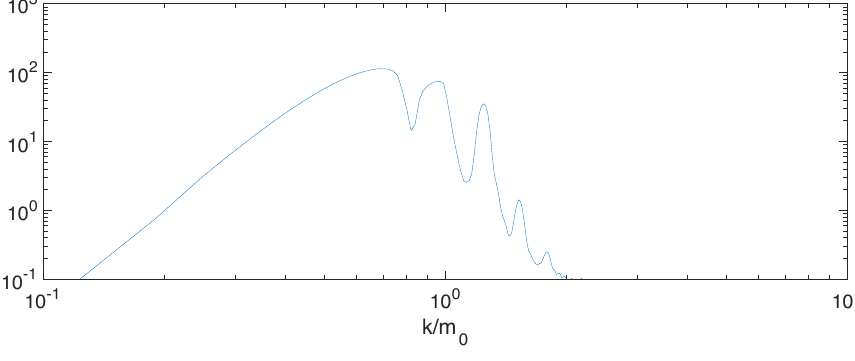
Figure 2 . A plot showing (cid:1) N ( k )